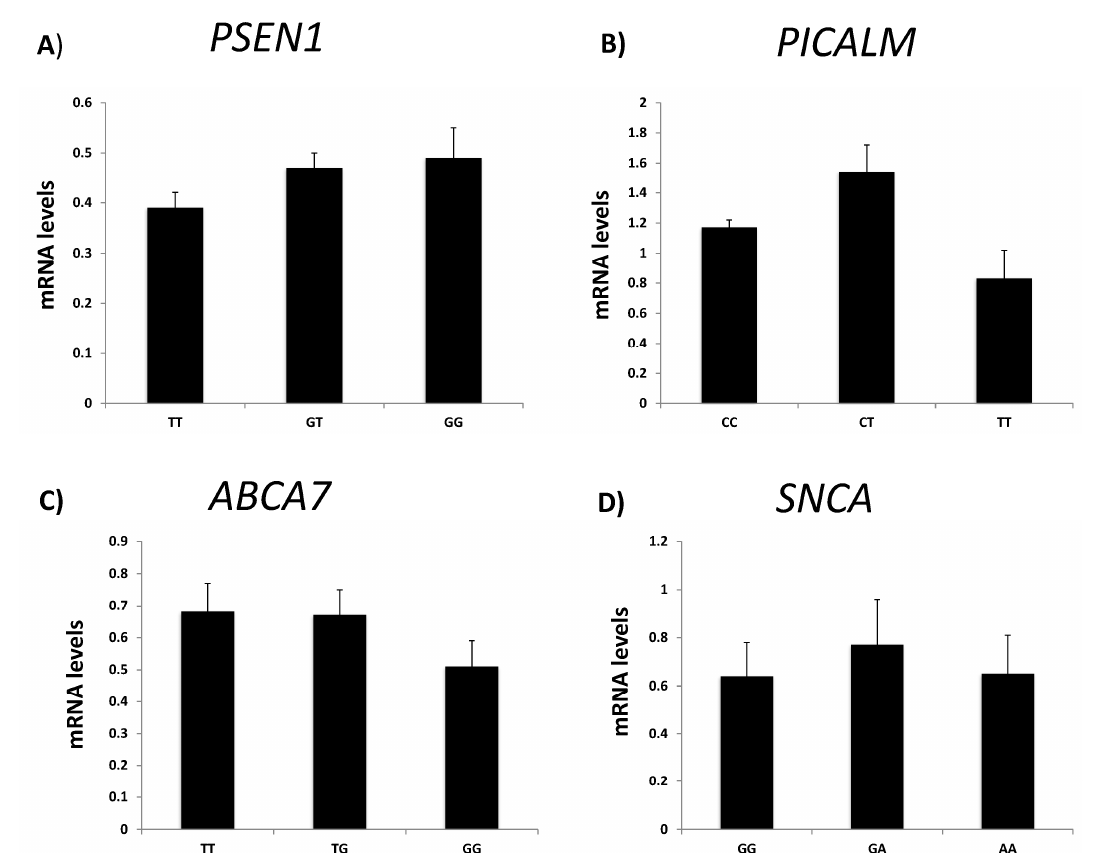
Figure 4. Gene expression in patients with different PSEN1 , PICALM , ABCA7 and SNCA genotypes. ( A ) PSEN1 , ( B ) PICALM , ( C ) ABCA7 and ( D ) SNCA mRNA levels were analyzed in bu ff y coat samples from patients with di ff erent genotypes. The labels for each bar on the x -axis refer to the different genotypes detected in the polymorphisms analyzed. Data are presented as means ± S.E.M. ABCA7, ATP-binding casse tt e, subfamily A, member 7; PICALM, phosphatidylinositol-binding clathrin protein; PSEN1, presenilin-1; SNCA, alpha synuclein.